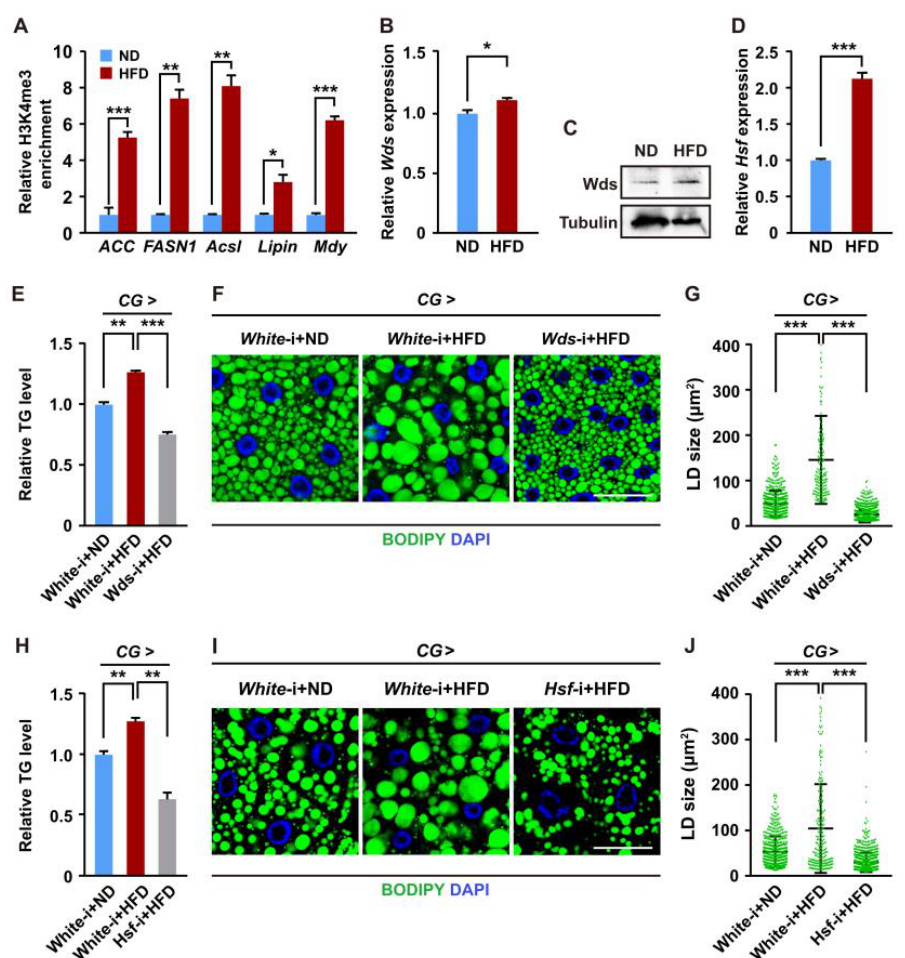
2.5. HFD Condition Promotes Wds-Mediated H3K4me3 in the Drosophila Fat Body Increasing evidence has demonstrated that dietary HFD condition can increase lipid accumulation and TG levels [24,38–40]. Given that Wds-mediated H3K4me3 modification promotes the transcriptions of lipogenic genes to affect lipid accumulation in the Drosophila fat body, we therefore investigated whether HFD could regulate Wds-mediated H3K4me3 modification. We used a normal diet (ND) or HFD to feed Drosophila larvae at the third larval instar. First, immunostaining and western blotting assays found that HFD feeding elevated global H3K4me3 levels in the fat body compared with ND feeding as a control (Figure S8A,B). ChIP-qPCR analysis showed that H3K4me3 enrichment within the pro- moters of lipogenic genes was upregulated following HFD feeding (Figure 5A). Second, HFD feeding upregulated the expressions of the Wds gene in the fat body at mRNA and protein levels (Figure 5B,C and Figure S8C). Hsf expression in the fat body of Drosophila larvae was also upregulated by HFD feeding (Figure 5D). Importantly, the epistatic analysis revealed that HFD feeding-induced elevation of TG levels and LD size in the fat body were diminished by fat body-specific knockdown of Wds or Hsf (Figure 5E–J). Altogether, these data indicate that HFD promotes Wds-mediated H3K4me3 modification within promoters of lipogenic genes by upregulating the transcription of Wds and Hsf , thus contributing to the increase in lipid synthesis in the Drosophila fat body.